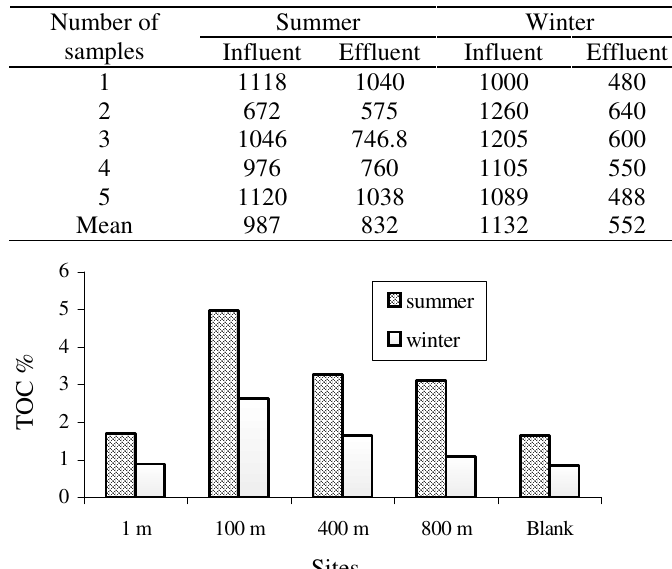
Figure 5. The average of BOD (ppm) in wastewater for both seasons. 5 Table 5. The average of COD (ppm) in wastewater for both seasons.